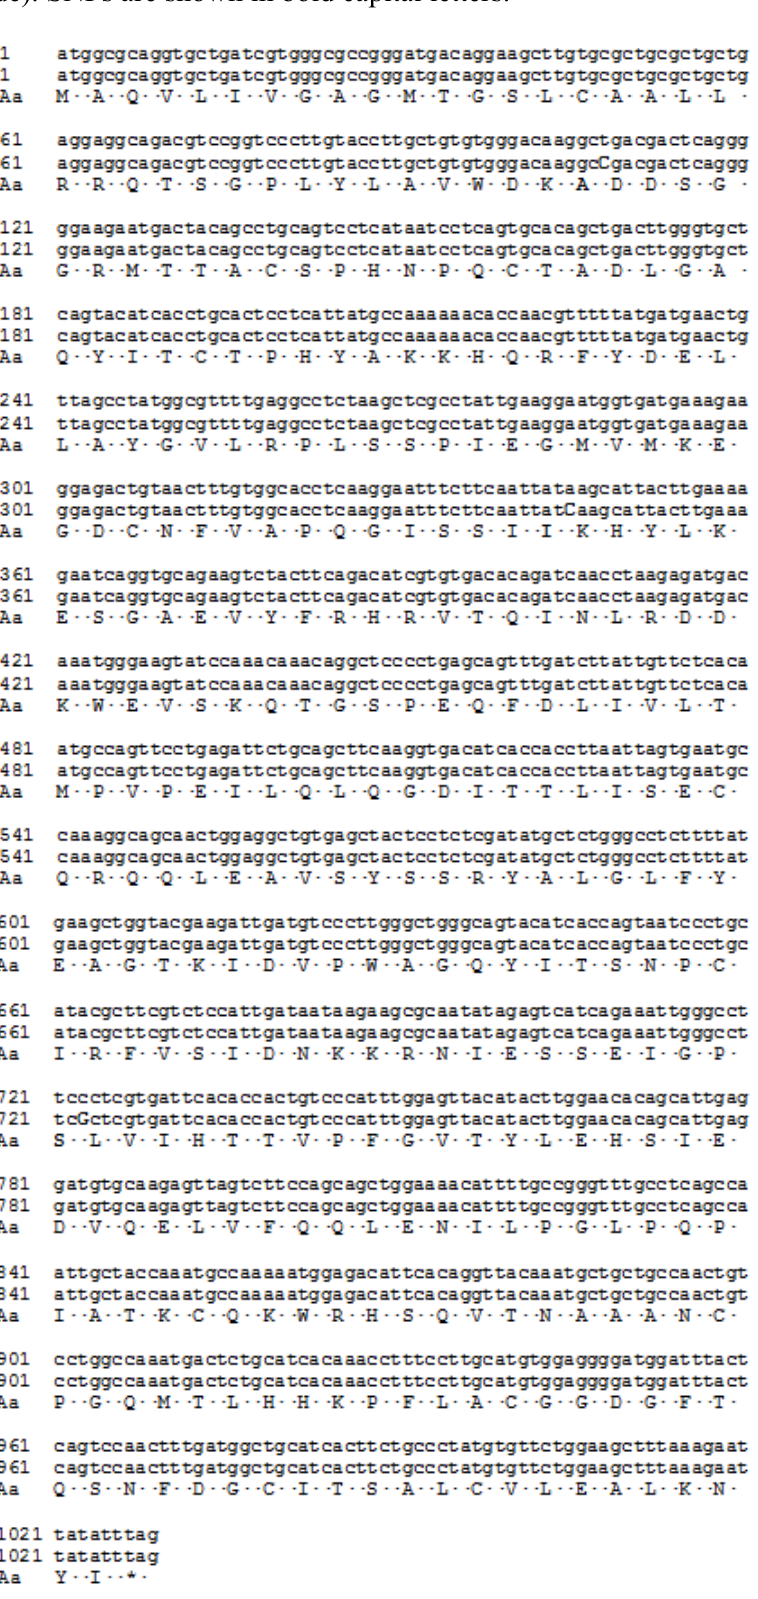
Figure 4. Nucleotide sequences of hRenalase1 ORF available from GenBank (locus NM_001031709.1; upper sequence). hRenalase1 ORF (median sequence) obtained in this study by sequential exon joining, and amino acid sequence of hRenalase1 (lower sequence, a one-letter code). SNPs are shown in bold capital